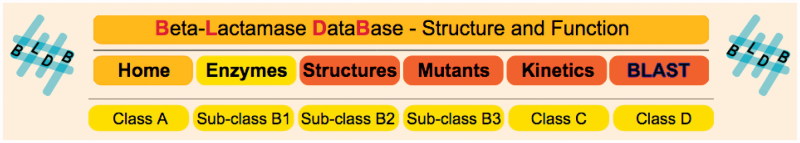
Global architecture of the Beta-Lactamase Database. In addition to the Home page, there are five main sections, dedicated to Enzymes (classified into the four classes A, B, C and D, and further into the three sub-classes of class B), three-dimensional Structures available in the Protein Data Bank, synthetic Mutants and hydrolytic profiles (Kinetics) described in the literature, and a graphical interface for BLAST queries.